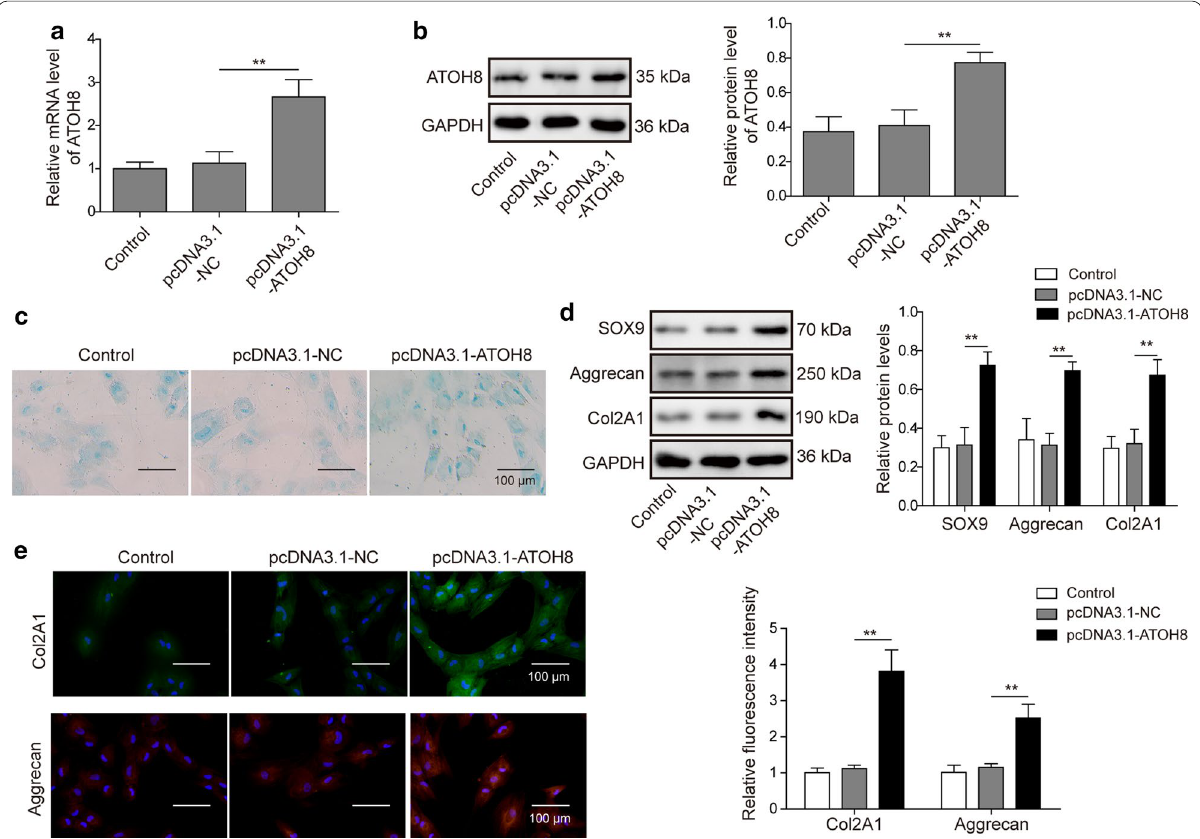
Fig. 3 Overexpression of ATOH8 promotes chondrogenic differentiation of hUC‑MSCs. a qRT‑PCR analysis of ATOH8 level in transfected cells. b Western blot analysis of ATOH8 protein level in transfected cells. c Alcian blue staining to analyze chondrogenic differentiation of hUC‑MSCs transfected with different constructs. d Western blot analysis of expression levels of SOX9, Aggrecan, and Col2A1 in transfected cells. e Immunostaining analysis of levels of Col2A1 and Aggrecan in transfected cells. n